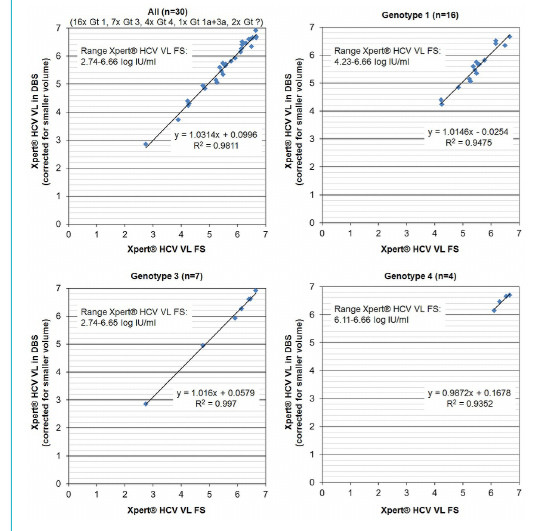
Figure 1: Quantitative performance of the Xpert ® HCV Viral Load (VL) test in dried blood spot (DBS) produced with 100 µl capillary whole blood. Correlation of quantifiable HCV RNA results (log IU/ ml) with the reference test Xpert ® HCV Viral Load Fingerstick (VL FS), overall and according to genotype (Gt).